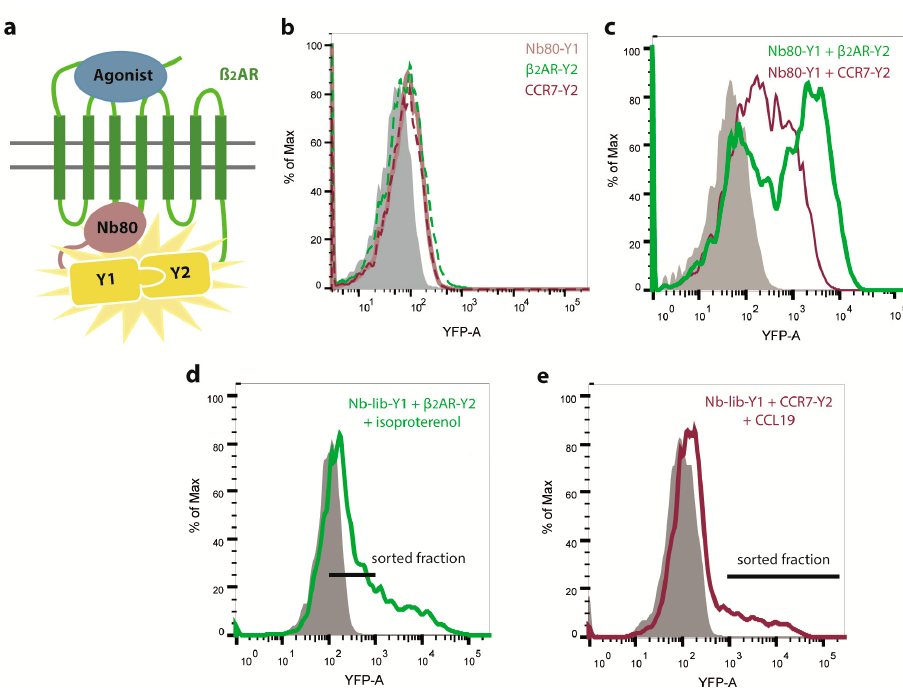
Figure 1. Engineering of nanobodies (Nbs) recognizing CCR7 by bimolecular fluorescence complementation (BiFC). Structure and sequence of the conformation-specific Nb80, which recognizes an isoproterenol-activated conformation of the β 2-adrenergic receptor ( β 2 AR), was used to specifically randomize complementarity determining region (CDR)1 and CDR3 to generate a new Nb library. The newly generated Nb library was fused to the N-terminal part of split-YFP (YFP1, Y1) in order to identify Nbs that recognize CCR7 fused to split-YFP2 (Y2) by BiFC. ( a ) Schematic illustration of BiFC between Nb80-YFP1 and β 2 AR-YFP2. Nb80 recognizes and binds to agonist activated β 2 AR. Thereby, the two split-YFP fragments will reconstitute to form native YFP. ( b ) Flow cytometric analysis of HEK293 cells transiently expressing either Nb80-YFP1 (dotted brown line), β 2 AR-YFP2 (dotted green line), or CCR7-YFP2 (dotted red line) alone. Untransfected, control cells are shown in grey. ( c ) Flow cytometric analysis showing BiFC in HEK293 cells transiently co-expressing Nb80-YFP1 and β 2 AR-YFP2 (green line) as proof of concept or Nb80-YFP1 and CCR7-YFP2 (red line) as control. Before measuring YFP fluorescence, cells were stimulated with isoproterenol (10 µ M) or CCL19 (0.5 µ g / mL), respectively. ( d ) Negative screening of Nb library to remove β 2 AR-recognizing Nbs. HEK293 cells were transiently transfected with the newly generated Nb library fused to split-YFP1 (Nb-lib-Y1) and β 2 AR fused to split-YFP2. After isoproterenol stimulation (10 µ M), BiFC-negative cells were FACS sorted to enrich the Nb library for Nbs that do not interact with β 2 AR anymore. Sorted cell fraction is indicated by the black line. Afterwards, plasmids coding for the Nb library were isolated. ( e ) BiFC of remaining Nb library-YFP1 and CCR7-YFP2. The Nb library-YFP1 was transiently expressed in HEK293 cells stably expressing CCR7-YFP2 and cells were stimulated with CCL19 (0.5 µ g / mL). BiFC-positive cells, indicated by the black line, were FACS sorted.